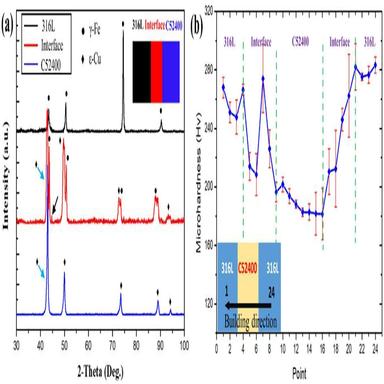
(a) XRD patterns of single metal and transition; (b) Microhardness along the building direction.